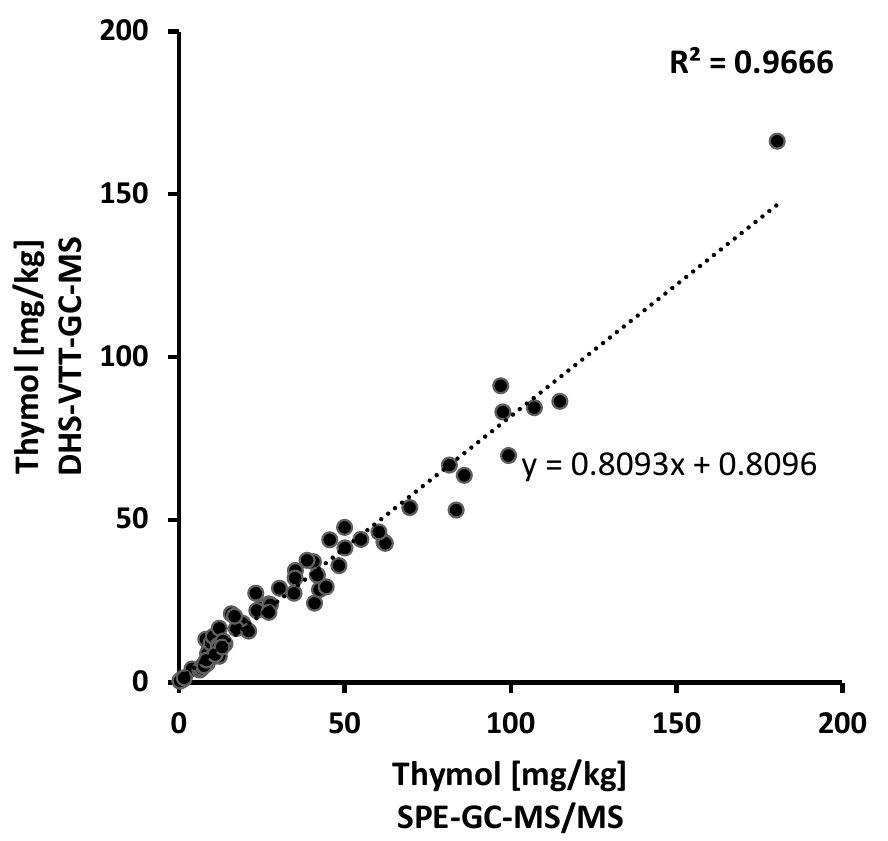
Figure 3. Quantitation of thymol in wax samples (N = 74) by SPE-GC-MS/MS analysis (x-axis) versus DHS-VTT-GC-MS analysis (y-axis).